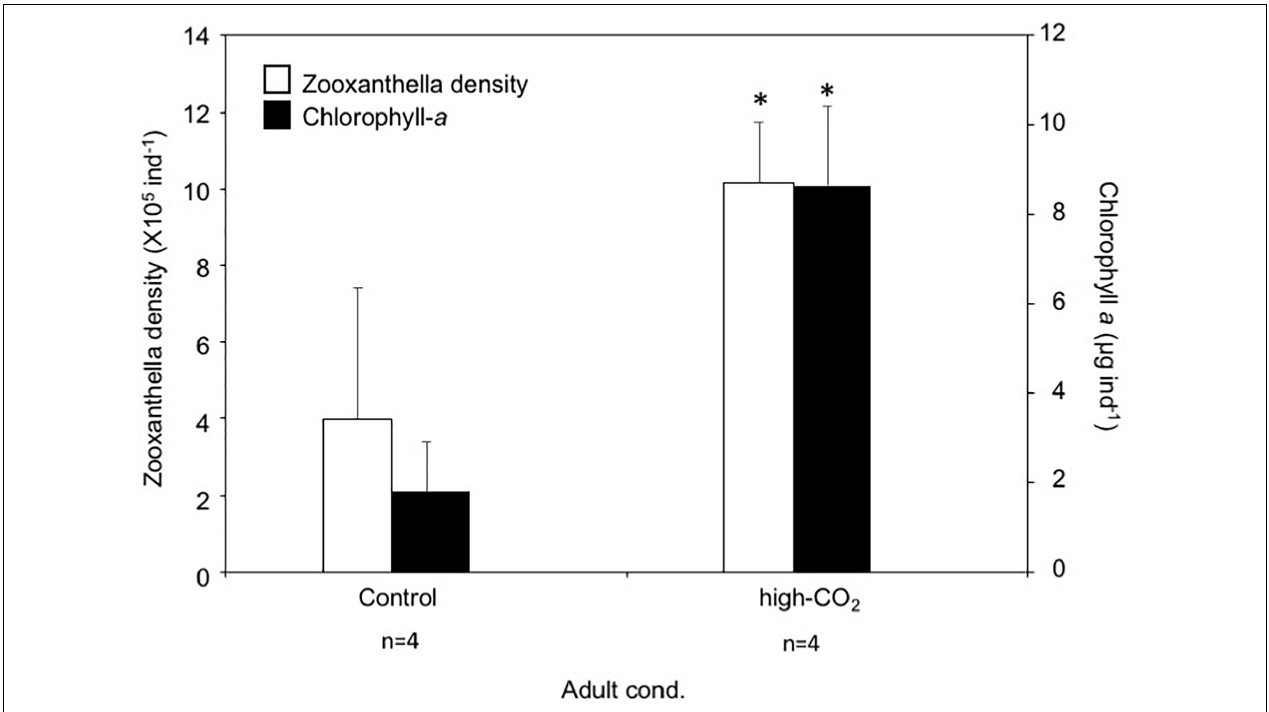
FIGURE 3 | Zooxanthella density and Chl- a concentration of Pocillopora acuta adults collected at control (white bar) and high-CO 2 (black bar) sites. Asterisks show significant differences among control and high CO 2 adults analyzed by t- test. The replicate number are shown as n in the graph. Average ± SD.